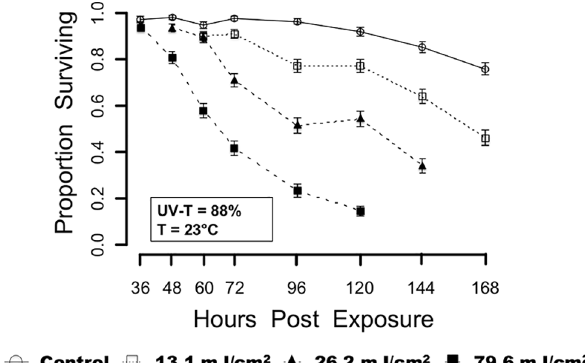
Fig 2. Mean proportion survival. Larval survival after exposure to one of four UV-C treatments. Mean ± SE bars shown.